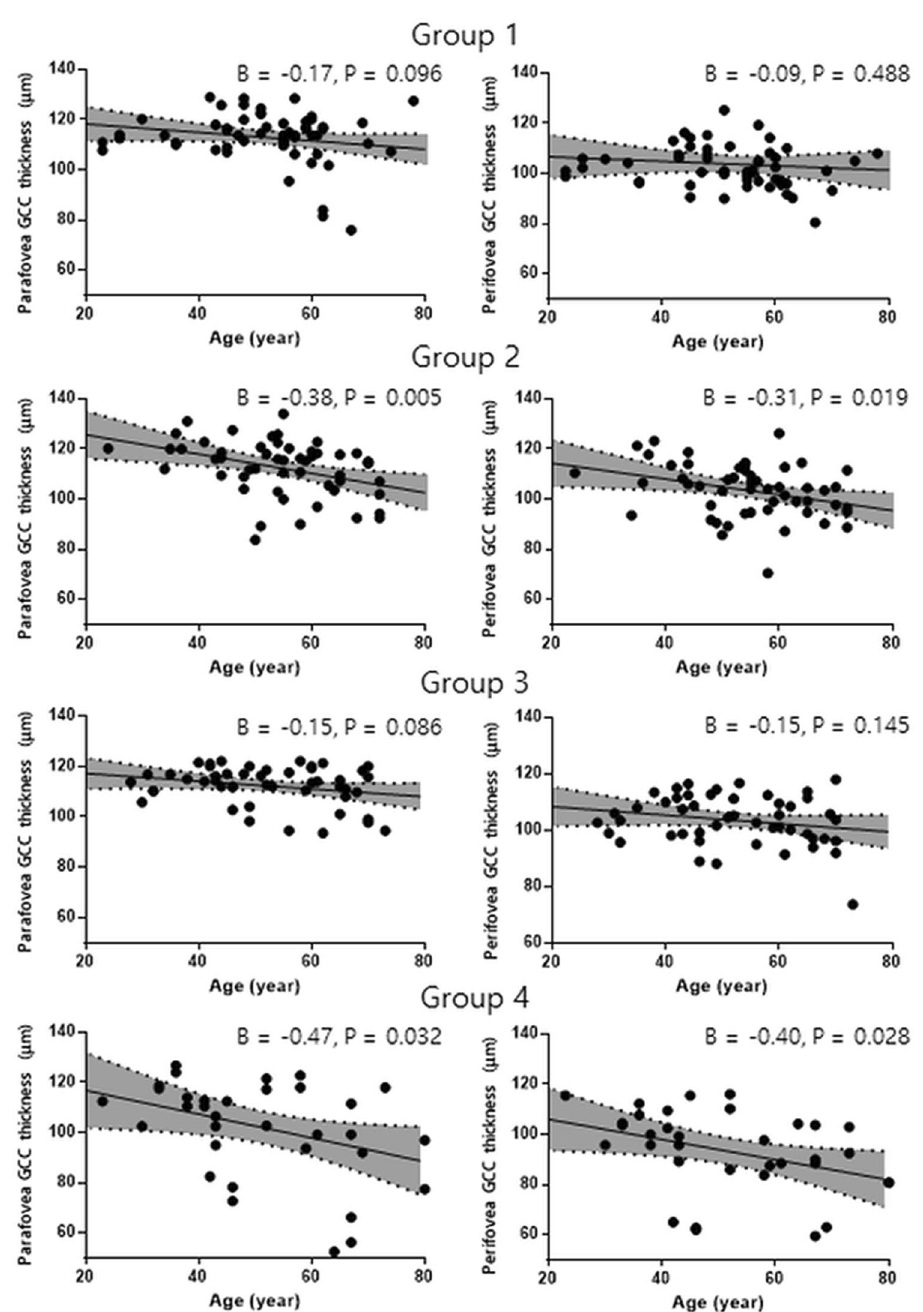
Figure 1. Scatterplots and results of linear regression analyses showing associations between parafoveal ganglion cell complex thickness and age in each